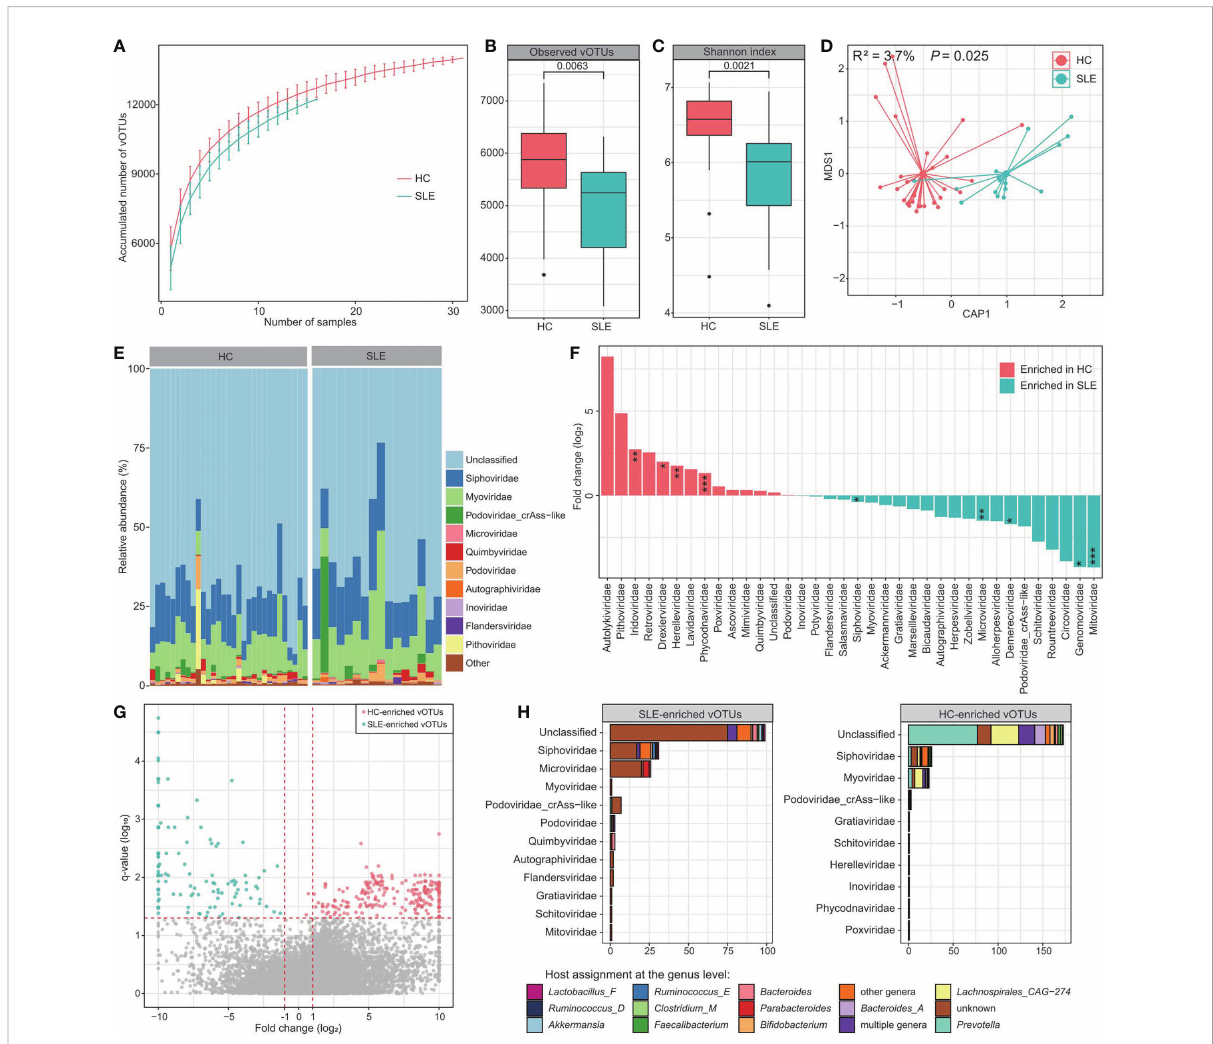
FIGURE 2 Difference in bulk gut virome between SLE patients and healthy controls. (A) Rarefaction curve analysis of the number of vOTUs on each group of samples. The number of identi fi ed vOTUs in different groups is calculated based on a speci fi c sample size with 10 random replacements, and the median and quartile numbers are plotted. (B, C) Boxplot showing the observed number of vOTUs (B) and Shannon diversity index (C) between two groups. The signi fi cance level is calculated using the Student ’ s t test. (D) dbRDA analysis based on the gut viral composition at the vOTU level, revealing the separations between SLE patients and healthy controls. The location of samples (represented by fi lled nodes) in the fi rst two multidimensional scales are shown. Lines connect samples that belonged to the same group. (E) Composition of bulk gut virome at the family level. (F) Barplot showing the fold changes of viral families when compared between patients and controls. The signi fi cance level in the Wilcoxon rank-sum test is denoted as: * adjusted P < 0.05, ** adjusted P < 0.01, *** adjusted P < 0.001. (G) Volcano plots showing the fold change vs. q-values for all vOTUs when compared between patients and controls. The X-axis shows the ratio (log2 transformed) of vOTU abundance in SLE patients (fold < 0) compared with that in healthy controls (fold > 0). The Y-axis shows the q-value (-log10 transformed) of a vOTU. Horizontal dotted lines: adjusted P < 0.05; vertical dotted lines: fold < -2 and fold > 2. (H) Taxonomic and host assignment of the SLE- enriched (left panel) and control-enriched (right panel) vOTUs. The vOTUs are grouped at the family level, and their hosts are shown at the genus